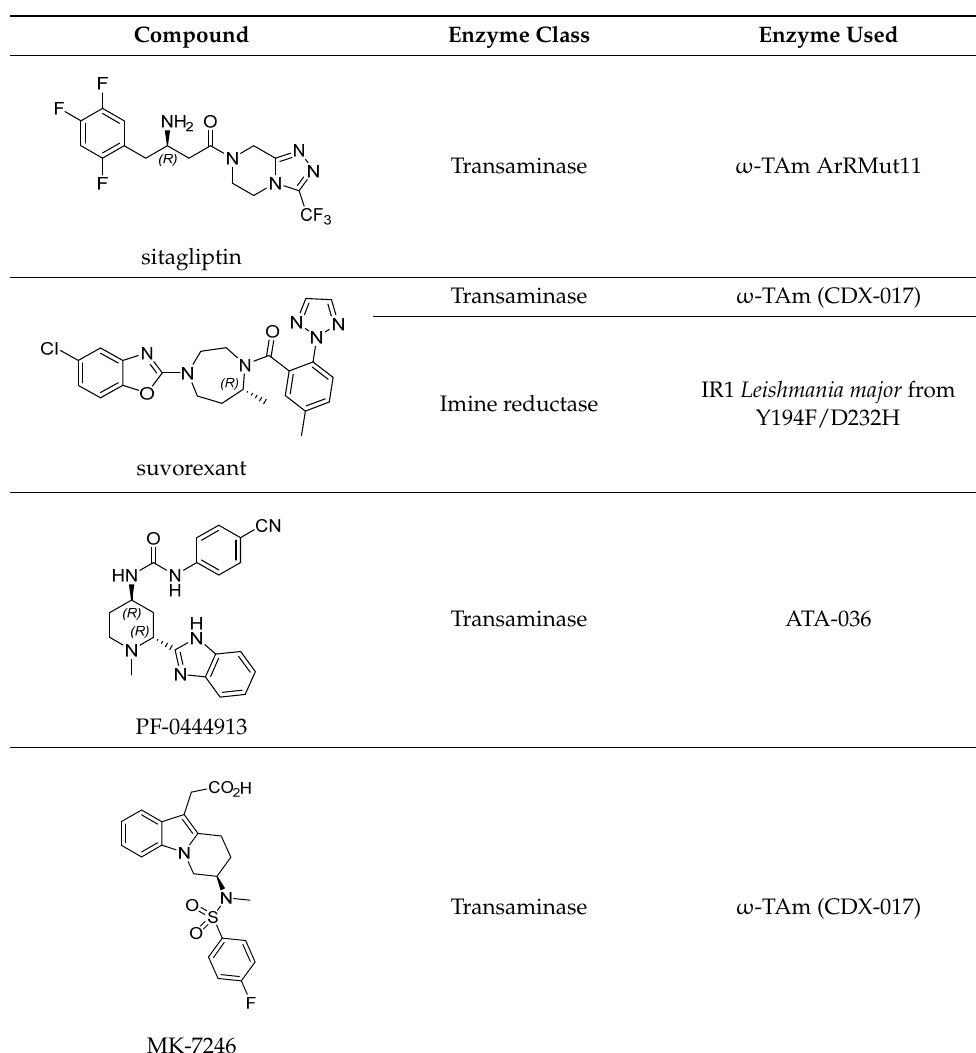
Table 1. List of compounds discussed in this review and enzymes used during their synthesis.